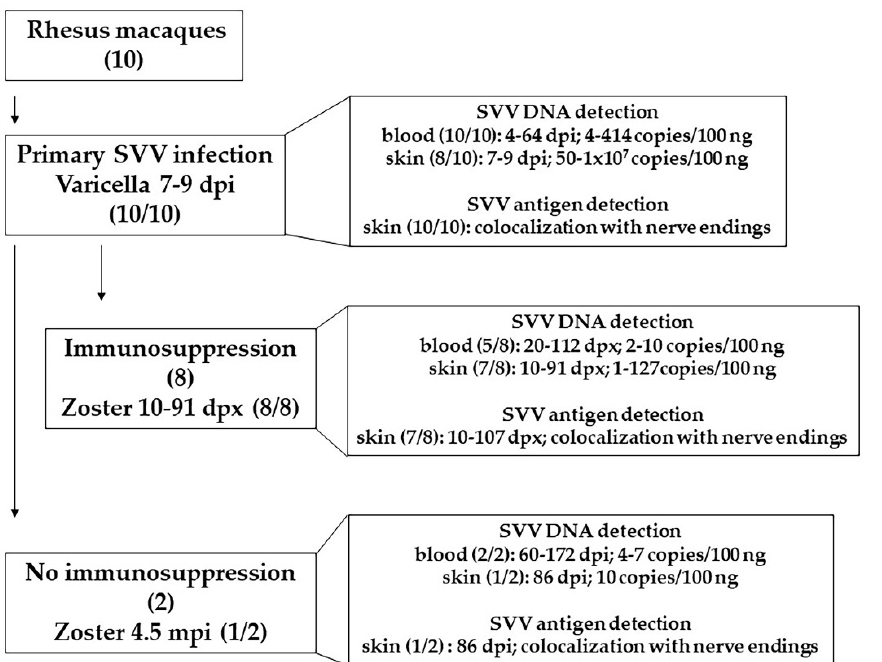
Figure 5. Summary of findings in this report. Ten rhesus macaques were inoculated with SVV. All of them developed varicella 7–9 dpi. SVV DNA (4–414 copies/100 ng) was detected in blood, 4–64 days post infection (dpi) in all 10 monkeys. SVV DNA (50–1 × 10 7 copies/100 ng) was detected